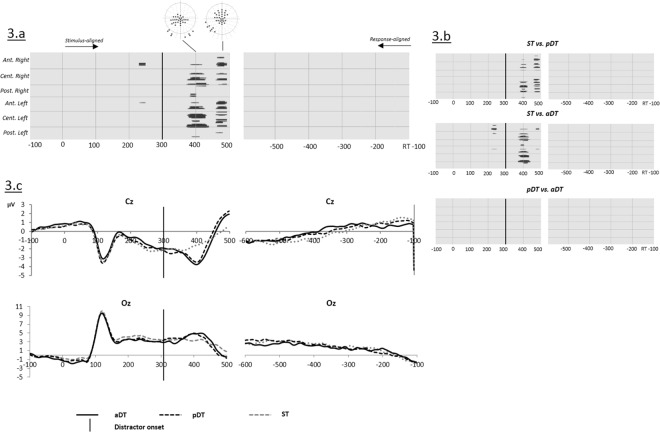
(a) Significant differences (ANOVA; p values) on ERP waveform amplitudes on each electrode (Y axis) and time point (X axis) between the three tasks (Single task ST, passive dual-task pDT and active dual-task aDT) when distractors used in dual-tasks were syllables. (b) Planned comparisons of significant differences on ERP waveform amplitudes on each electrode (Y axis) and time point (X axis). (c) Example of group averaged ERP waveforms for ST (dotted gray), pDT (dotted black) and aDT (solid black) on electrodes Cz and Oz. Vertical black solid lines indicate the onset of the distractors in dual-tasks.